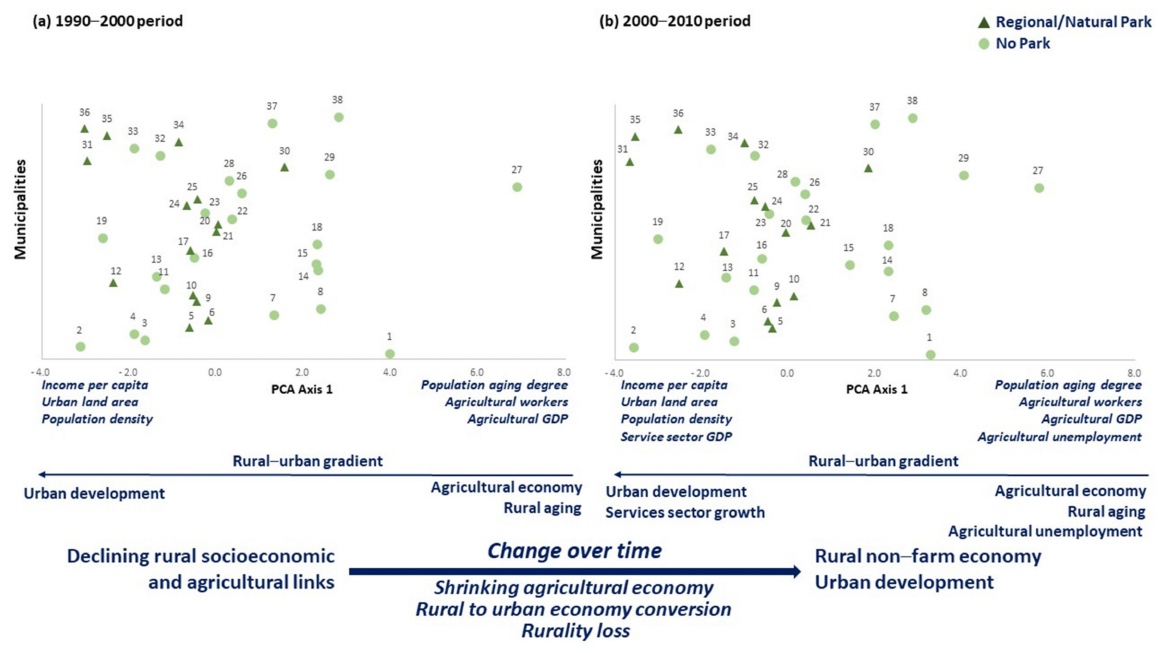
Figure 5. Socioeconomic dynamics. Coordinates of the municipalities of the study area along PCAs-axes 1: ( a ) period 1990–2000; ( b ) period 2000–2010. Socioeconomic indicators (variables with higher loadings in the PCAs) are shown at both ends of the axes (see Table 2). The codes of the municipalities are indicated in Appendix